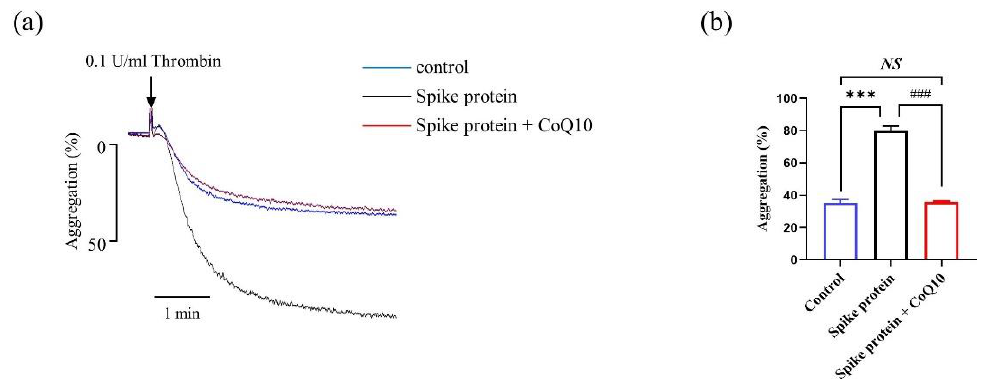
Figure 3. CoQ10 attenuates spike protein-potentiated platelet aggregation. Platelets were incu- bated with 100 µ M CoQ10 or solvent for 50 min in the dark, then incubated with 2 µ g/mL spike protein for 10 min. The samples were then activated with 0.1 U/mL thrombin, and the platelet aggregation was monitored for 5 min. ( a ) Representative traces and ( b ) summary data were presented ( n = 3). All data are presented as mean ± SEM. *** p < 0.001 indicates a significant difference compared to the control group. ### p < 0.001 indicates a significant difference between two groups. NS , no significant difference between two groups.